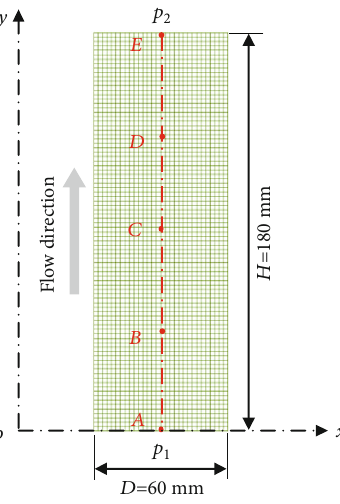
Figure 2: Numerical model. Table 1: Physical and seepage parameters employed for